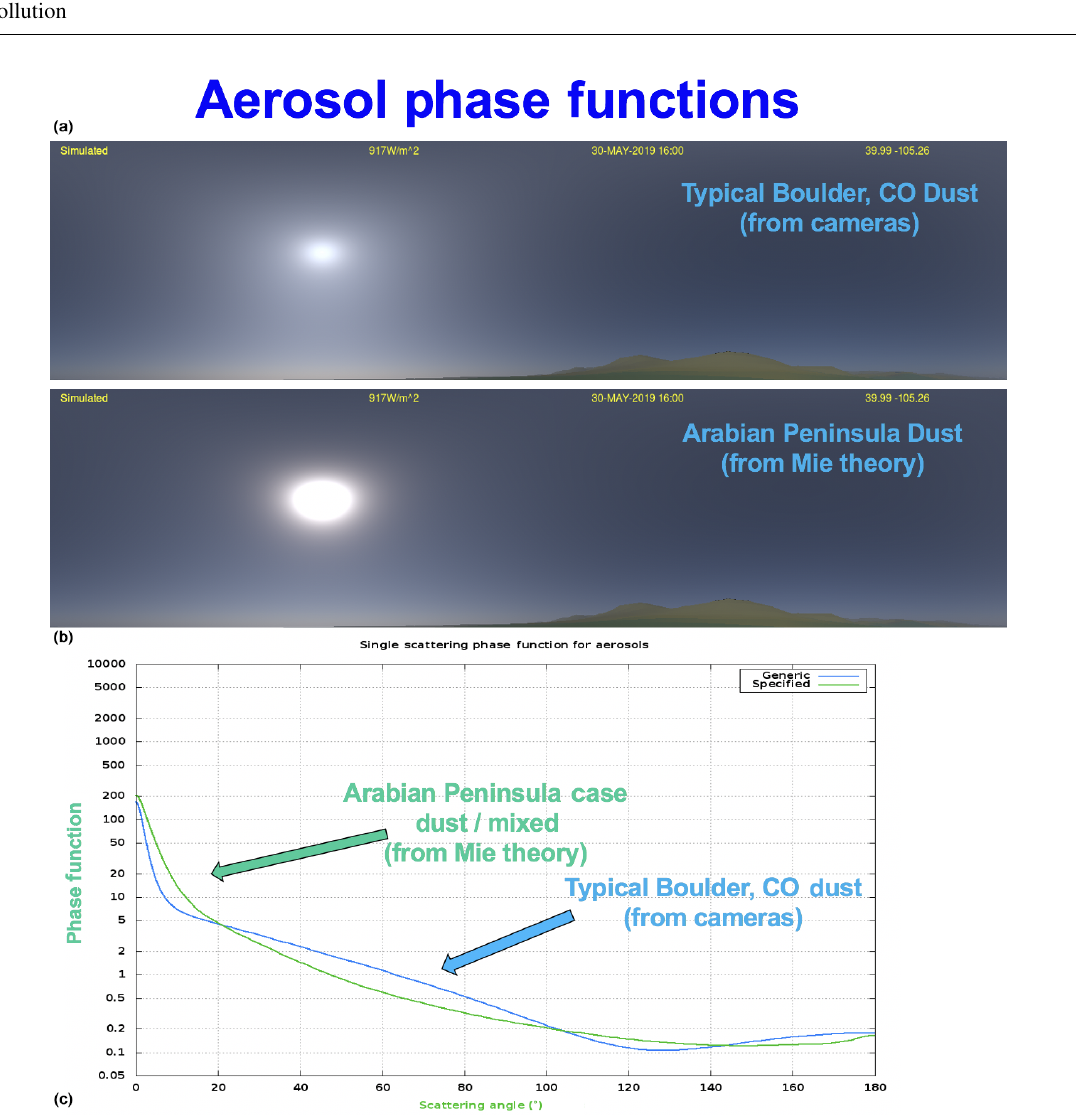
Figure 4. Simulated panoramic images with an aerosol optical depth of 0.1 using (a) the Colorado empirical phase function and (b) the Mie theory mixed dust case. These two phase functions are compared in (c)